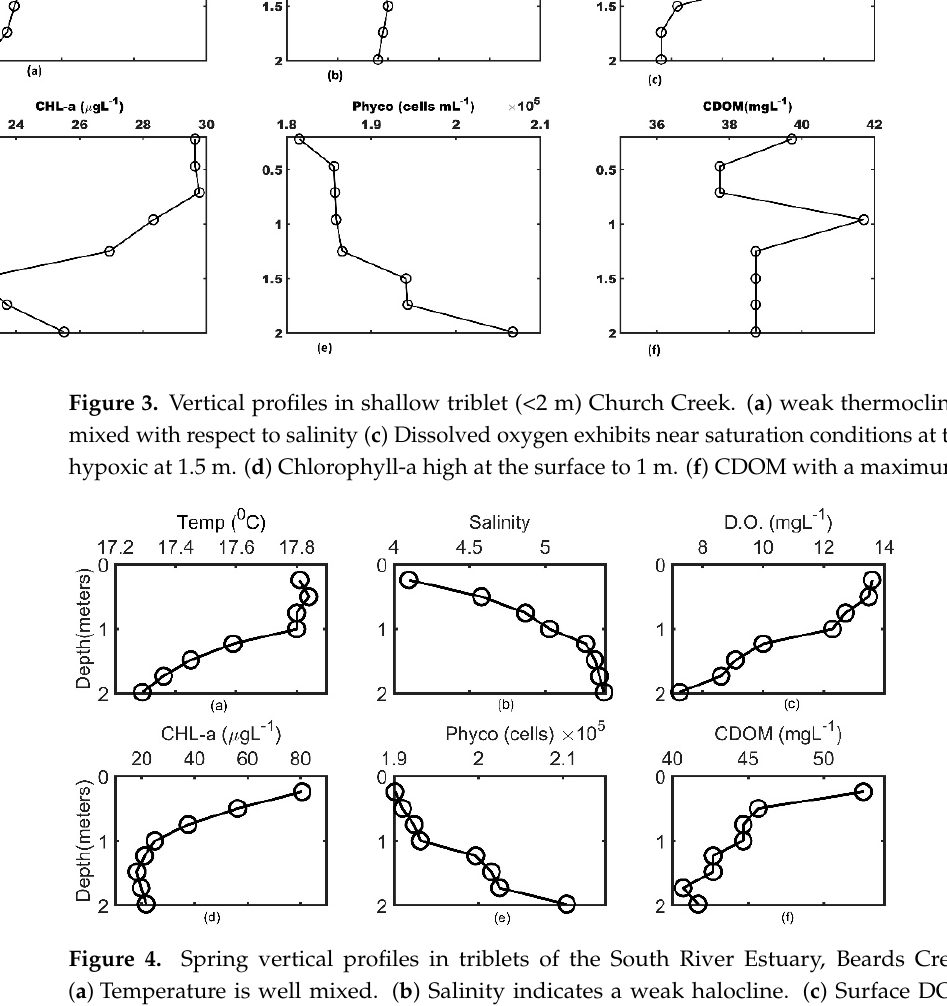
Figure 3. Vertical profiles in shallow triblet (<2 m) Church Creek. ( a ) weak thermocline ( b ) well ‐ mixed with respect to salinity ( c ) Dissolved oxygen exhibits near saturation conditions at the sur ‐ face, hypoxic at 1.5 m. ( d ) Chlorophyll ‐ a high at the surface to 1m. ( f ) CDOM with a maximum at 1m.